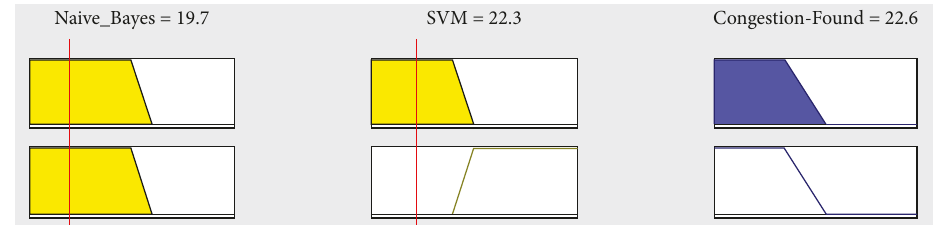
Figure 3: Rule diagram of the proposed 5G congestion control model (No).